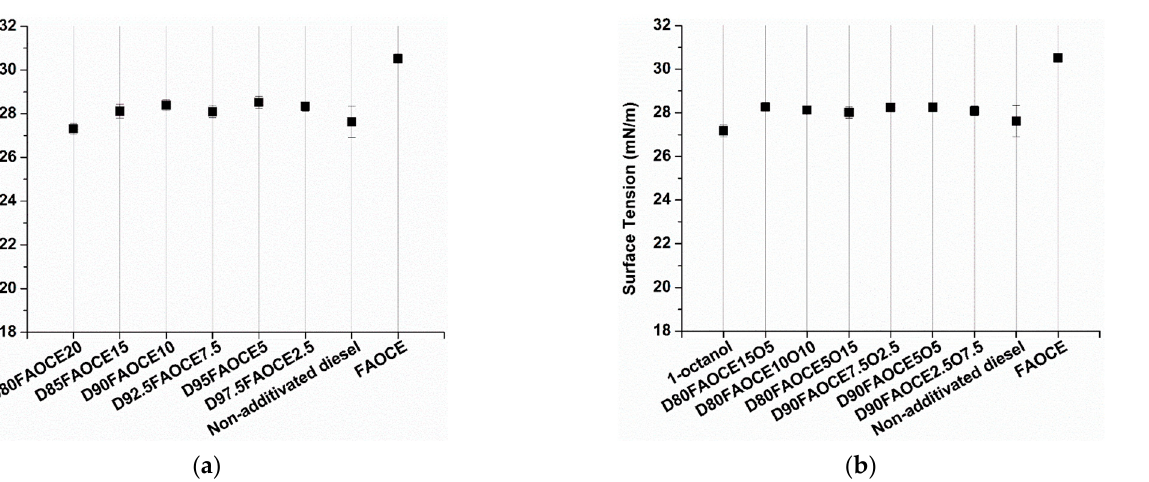
Figure 10. Surface tension values of pure components and their binary ( a ) and trinary ( b ) blends with mineral diesel.